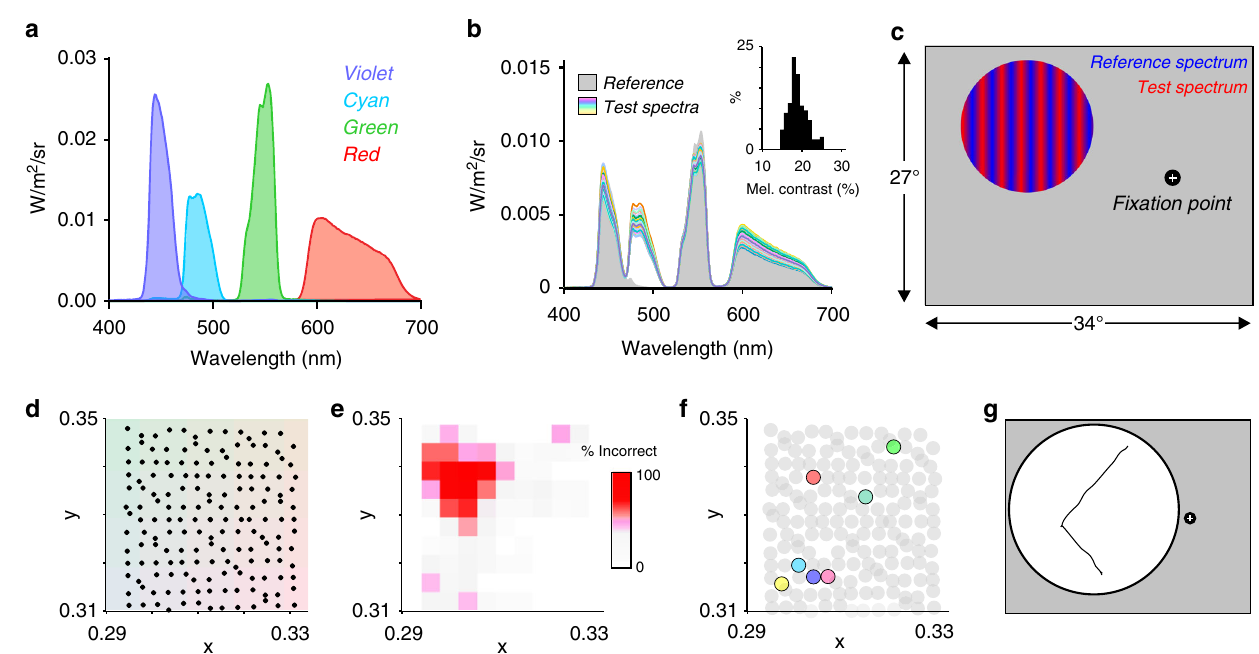
Fig. 1 Psychophysical paradigm and online-tuning procedure used to identify metameric stimuli. a Spectral power distributions of the four primaries (violet, cyan, green and red). b Spectral power distributions of reference (grey) and test stimuli (coloured lines, lower panel) used to identify a metameric stimulus for each participant. Inset histogram plots the range of measured melanopsin contrasts between all reference and test spectra. c Diagram of stimulus presentation. Stimuli were presented on a projection screen occupying 27 × 34° of visual space. All participants were instructed to fi xate on a cross with their left eye; all stimuli were presented within a circle (15° diameter), with centre located 20° from fi xation point (6.5° above horizon; 19° in temporal direction). Sinusoidal gratings formed by mixing reference and test spectra in different ratios were presented in one of four orientations. d Predicted location of test stimulus spectra in xy colour space. Reference spectrum was held constant at x = 0.31 y = 0.33 (central point). e Heat map showing the proportion of incorrectly identi fi ed orientations for gratings formed by test and reference spectra as a function of the predicted xy coordinate of the test stimulus (x = 0.31 y = 0.33) for a representative participant. Note that incorrectly identi fi ed gratings cluster for test spectra in a particular region of colour space. f xy colour coordinate of the test stimulus (coloured circles) that was judged to be metameric to the reference stimulus (central point) for